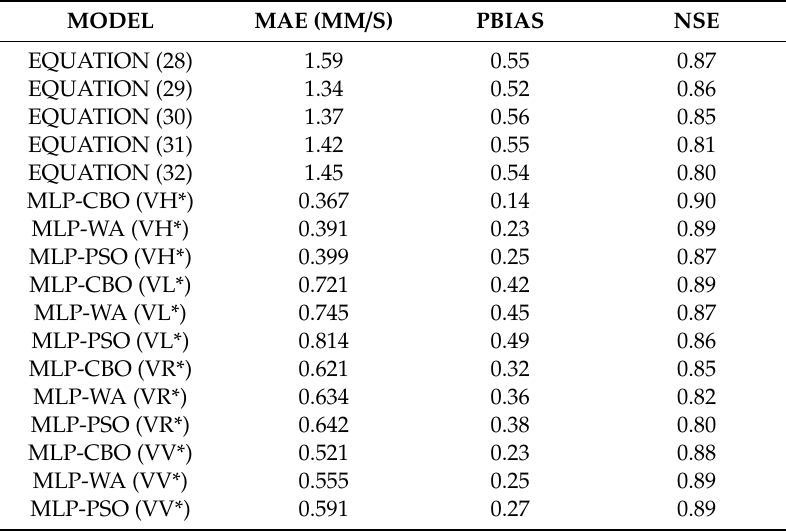
Table 4. The results of models for all